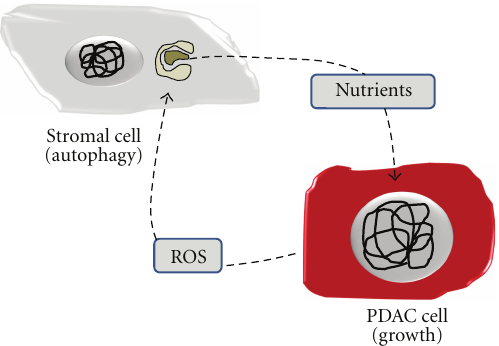
Figure 3: Chemotherapeutics agents induce autophagy. Gemc- itabine induces expression of the autophagy starter protein VMP1 and CB1 and CB2 cannabinoids receptors, and production of ROS. Cannabinoids induce autophagy by activating ER stress and enhance gemcitabine action.